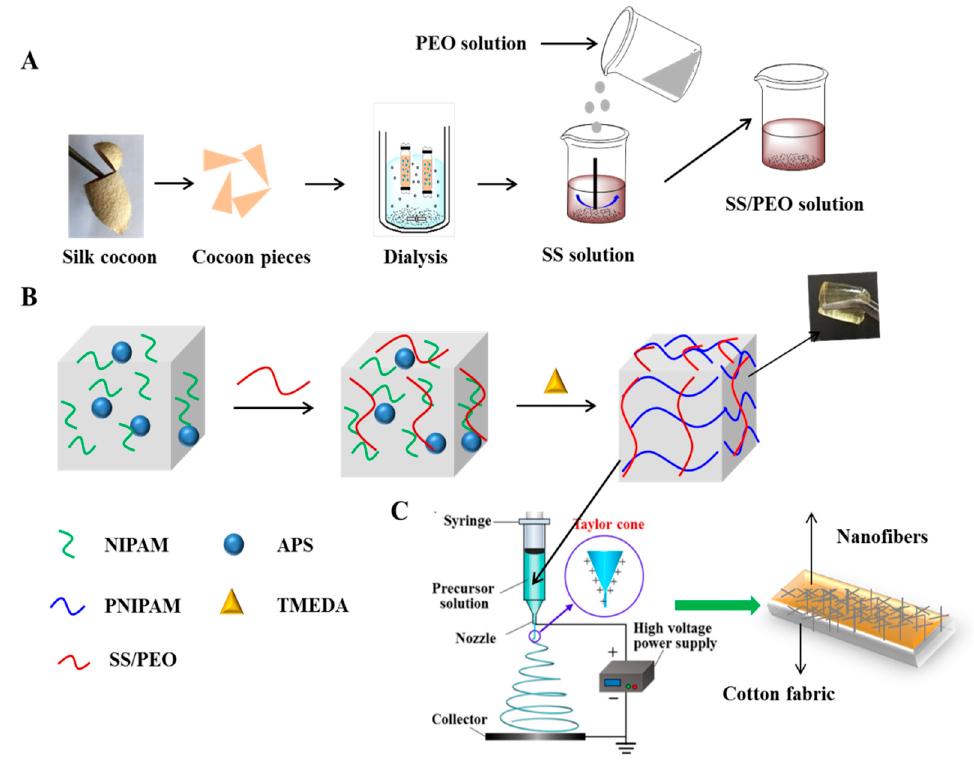
Figure 2. Schematic illustration of the ( A ) fabrication and ( B ) preparation of multifunctional cotton fabric.